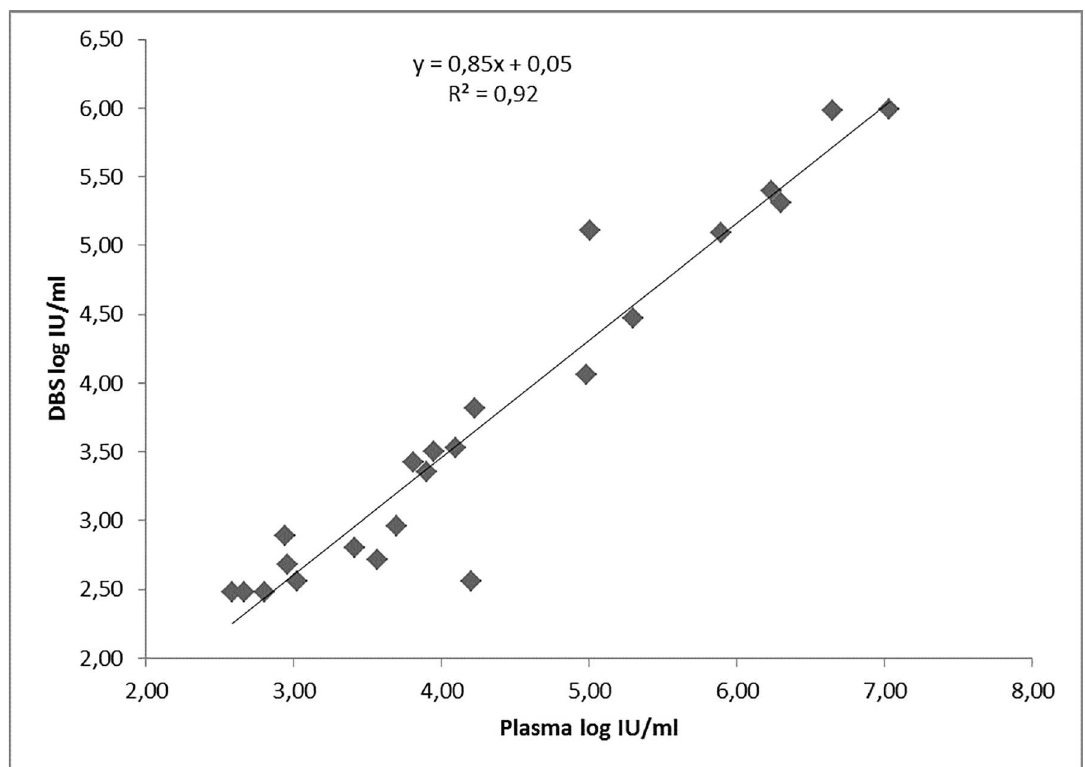
Fig 1. Regression analysis of HBV DNA levels in 23 paired plasma and Dried Blood Spot (DBS) specimens from Ethiopian hepatitis B patients